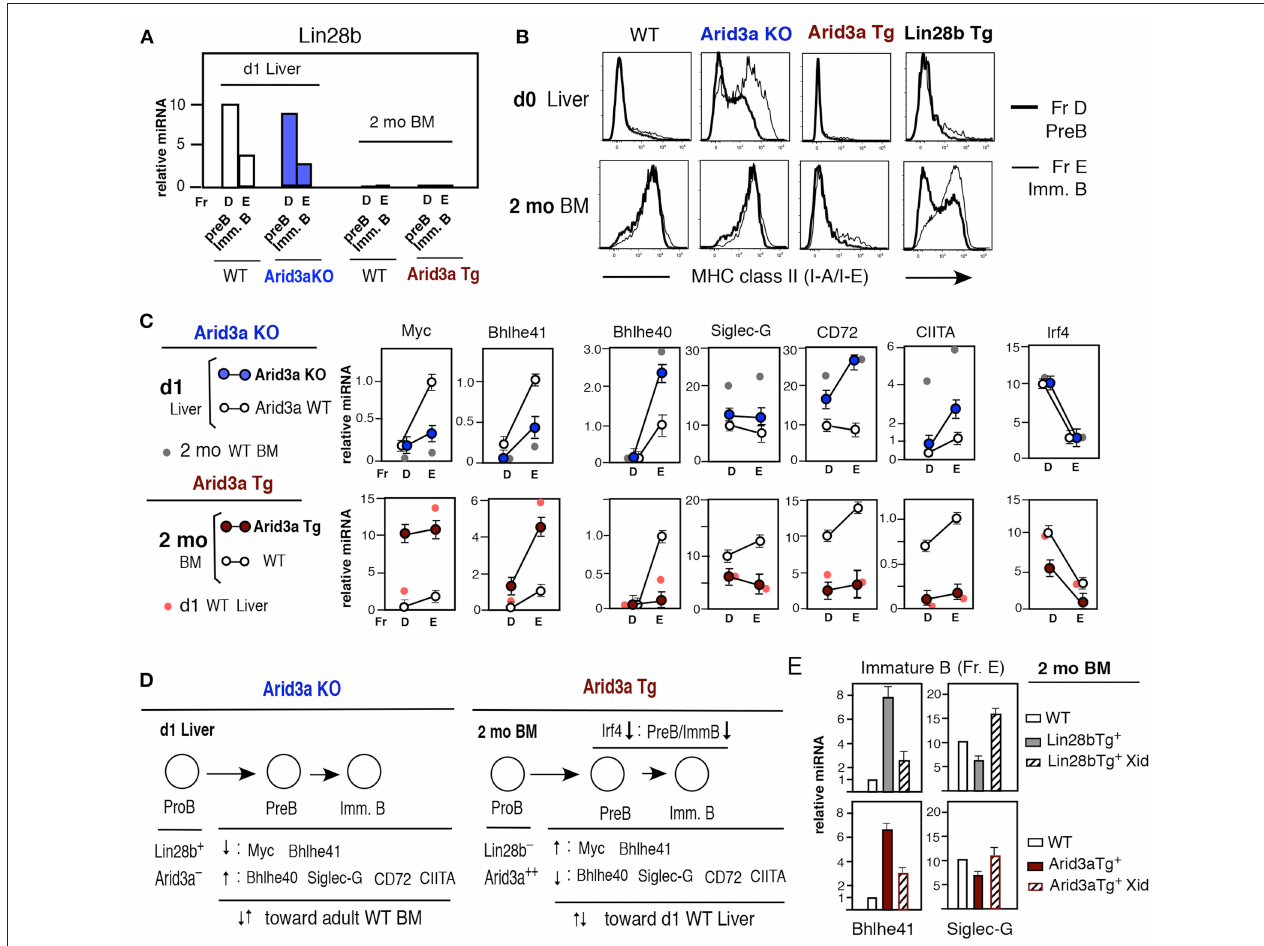
FIGURE 5 | Altered Arid3a level impacts levels of various mRNAs at the pre-B and immature B cell stages in neonatal liver and adult BM. (A) Lin28b qRT-PCR of pre-B and immature B cells in d1 liver Arid3a KO and Arid3a WT mice, and 2 mo BM Arid3a Tg + and Tg − WT mice. Two to three mice each. Lin28b expression in d1 liver and lack in adult BM were all similar. (B) MHC class II staining of d0 liver and 2 mo BM pre-B and immature B cells in WT, Arid3a KO, Arid3a Tg, and Lin28b Tg mice. (C) qRT-PCR of pre-B and immature B cells. d1 liver; Arid3a KO mice ( n = 3, mean ± s.e.) and Arid3a WT mice ( n = 2, mean ± s.e.) and addition of 2 mo normal mouse (WT C57BL/6) BM ( n = 2, mean) for comparison. 2 mo BM; Arid3a Tg ( n = 4, mean ± s.e.) and Arid3a Tg − (WT) ( n = 3, mean ± s.e.), and addition of d1 normal mouse liver ( n = 2, mean). (D) Summary of alteration of Arid3a KO d1 liver mRNAs and Arid3a Tg 2 mo BM mRNAs. (E) Lin28b Tg and Arid3a Tg mice were crossed with Xid mice. Bhlhe41 and Siglec-G mRNA comparison in immature B cells (Fr. E) with or without Xid, and normal WT immature B cells as a control, in 2 mo BM mice. n = 3 each; mean ± s.e.